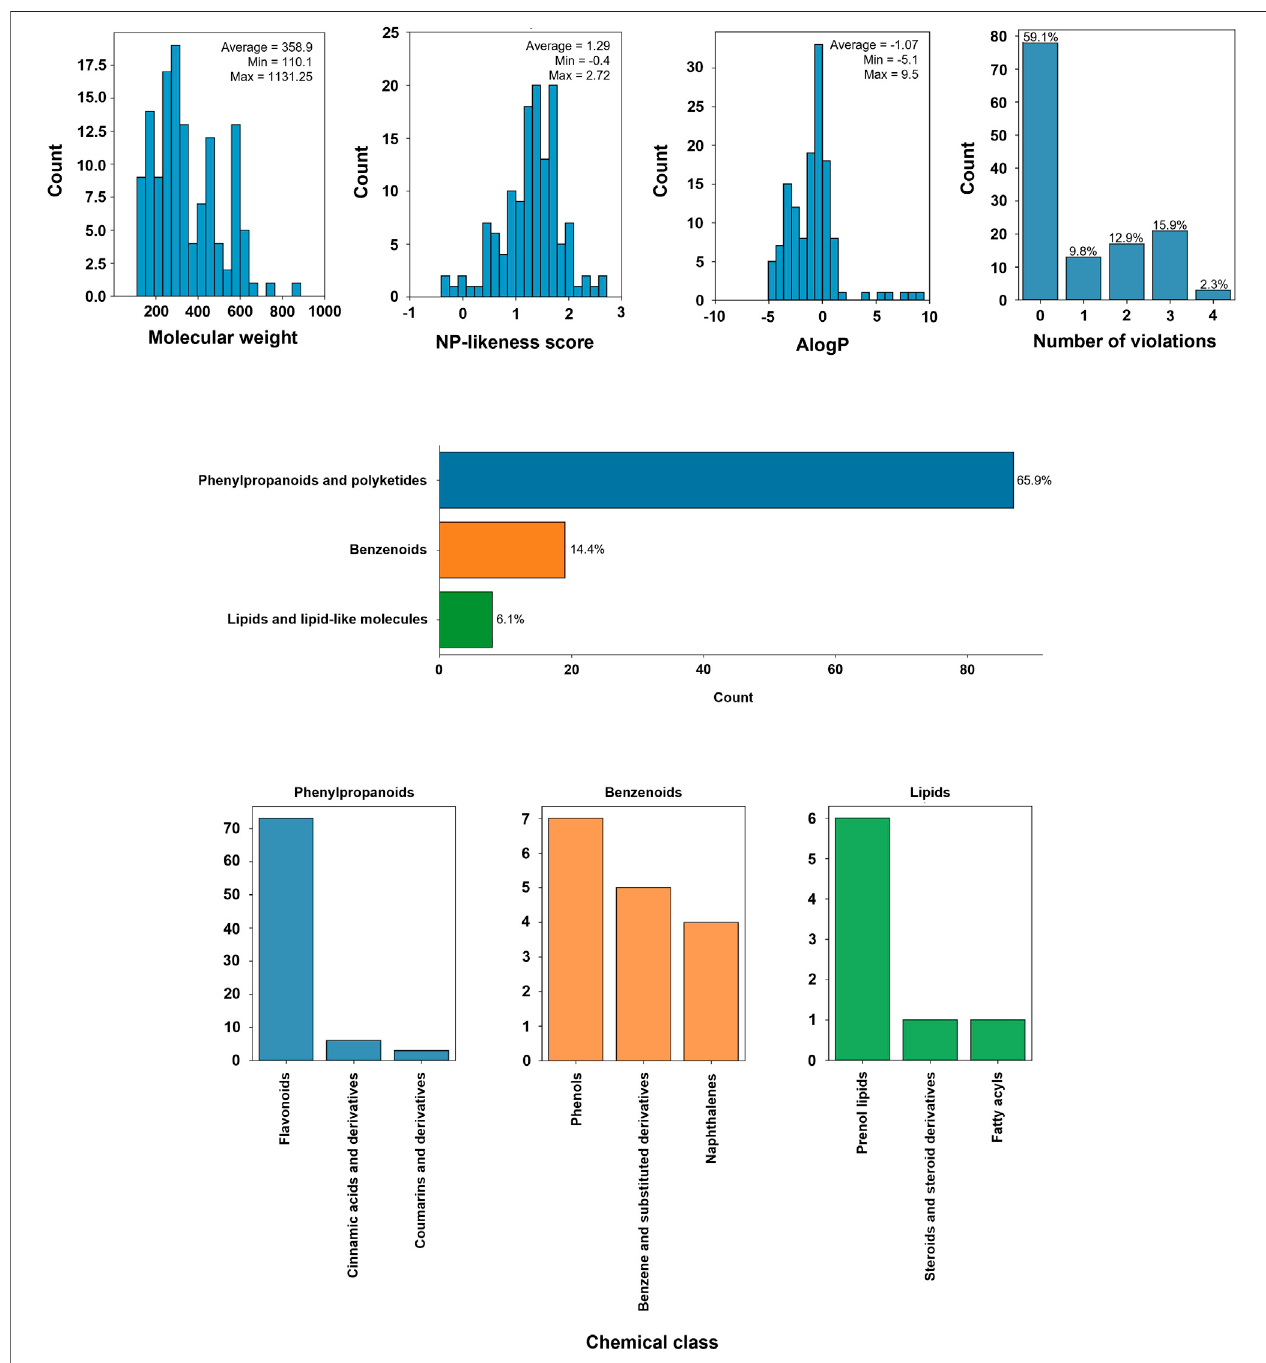
FIGURE 1 | Physico-chemical properties of the library used (molecular weight, NP-likeness score, AlogP, Number of Lipisnki violations), and distribution of the chemical (super)classes of the molecules present in the library.